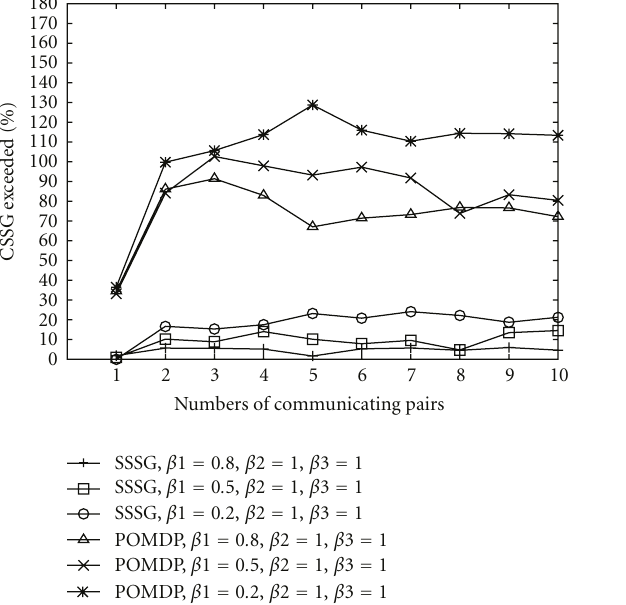
Figure 16: Aggregate throughput of CSSG with 2 channels having PUs’ interference.